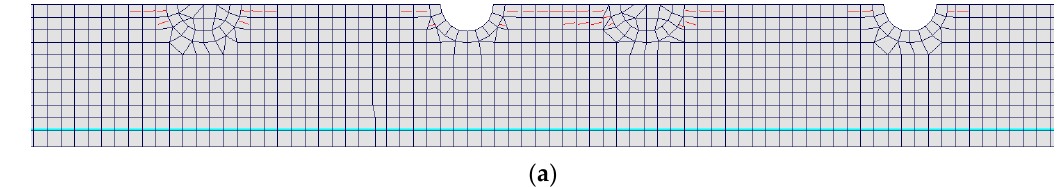
Figure 7. Evolution of the maximum crack opening in Z3 for the different type of dowels: ( a ) D1; ( b ) D2; ( c ) D3; ( d ) D4.